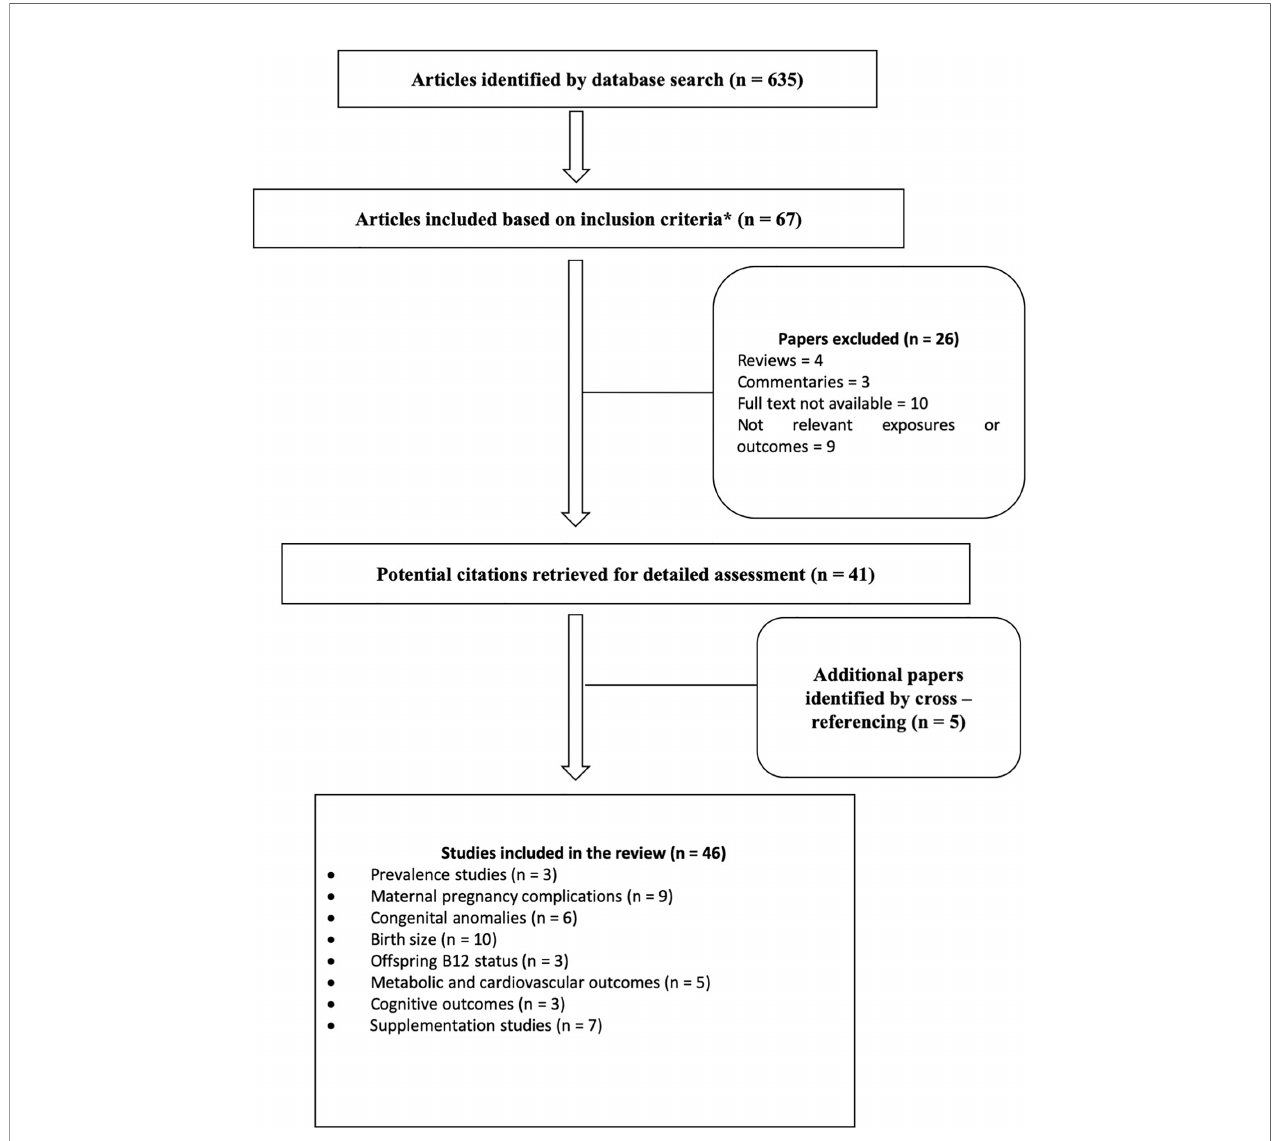
FIGURE 1 | .Flow diagram illustrating selection of articles in